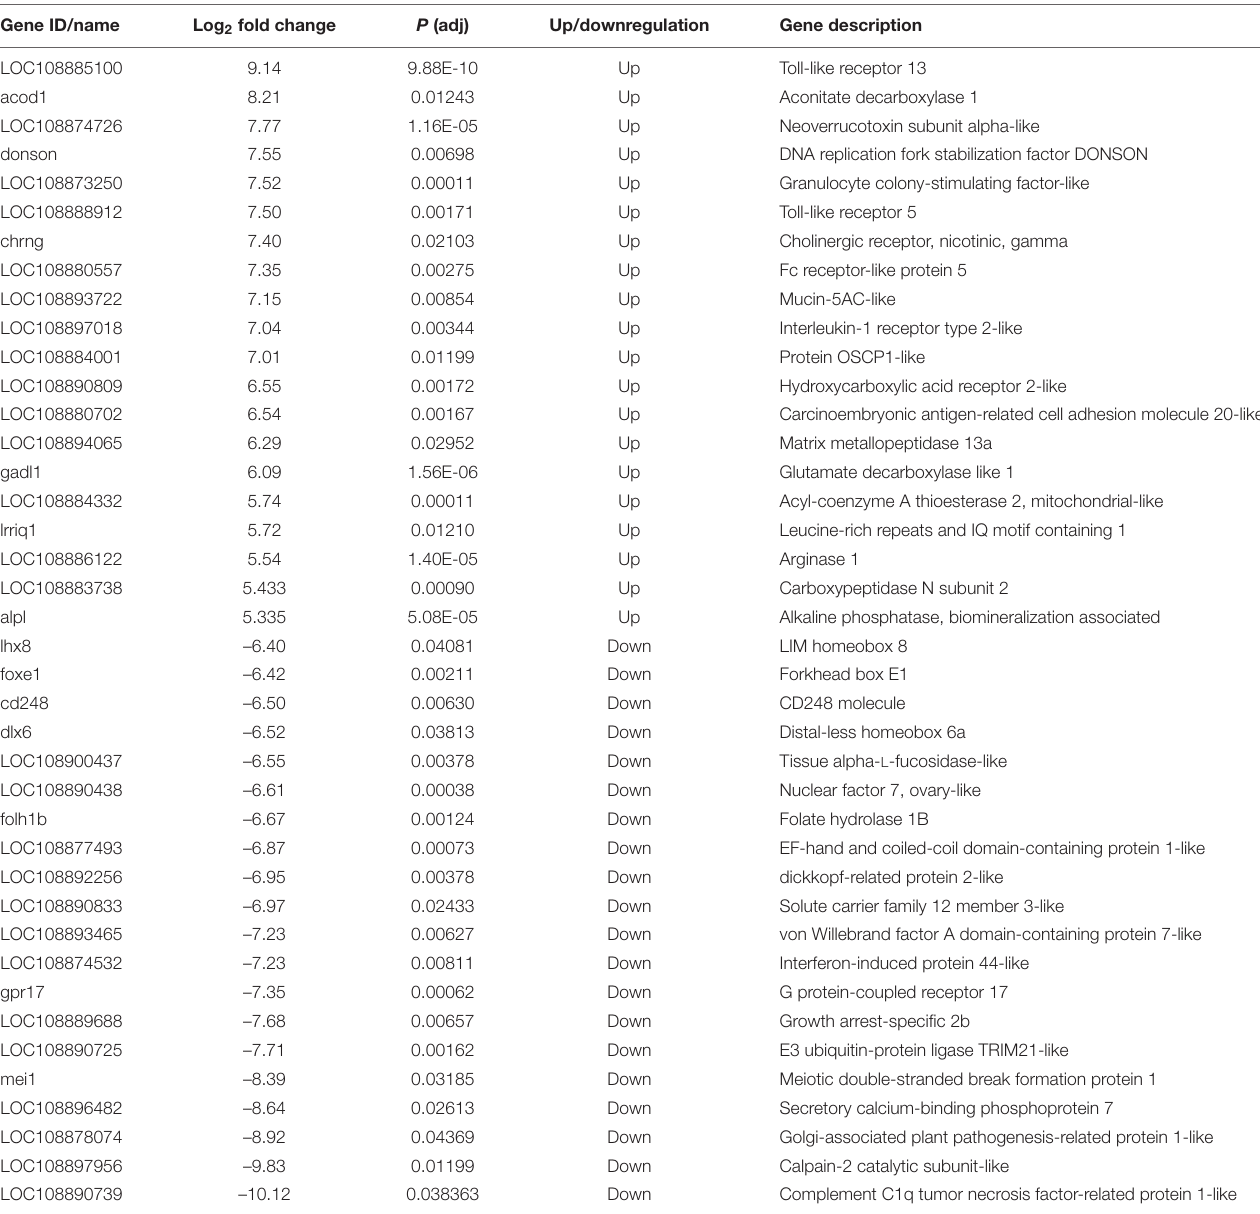
TABLE 3 | The top 20 significantly up- or downregulated genes in muscle of sick barramundi.